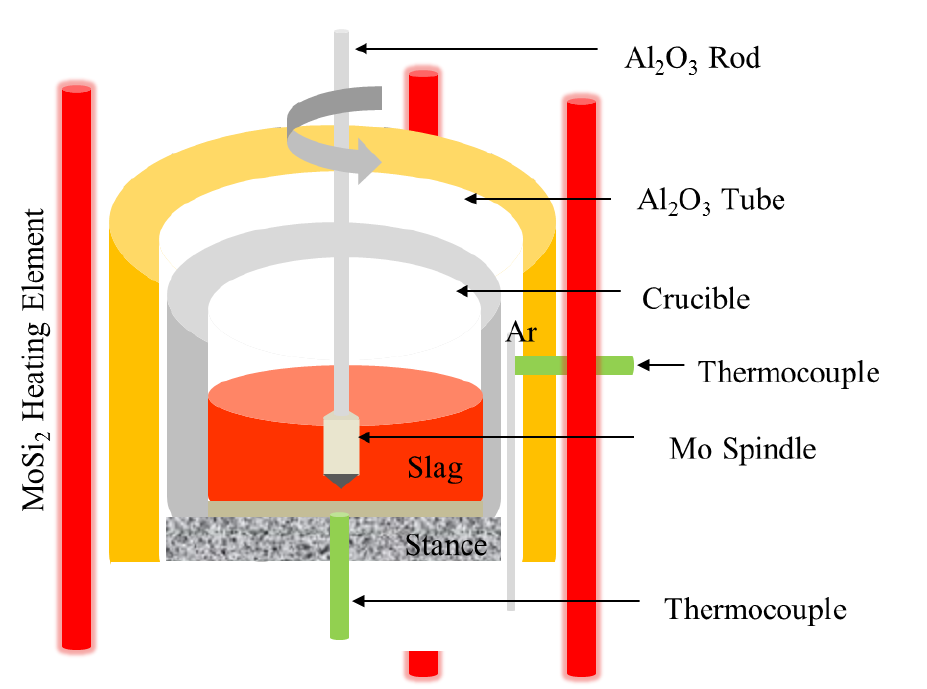
Figure 1. Schematic illustration of the apparatus for viscosity measurement.